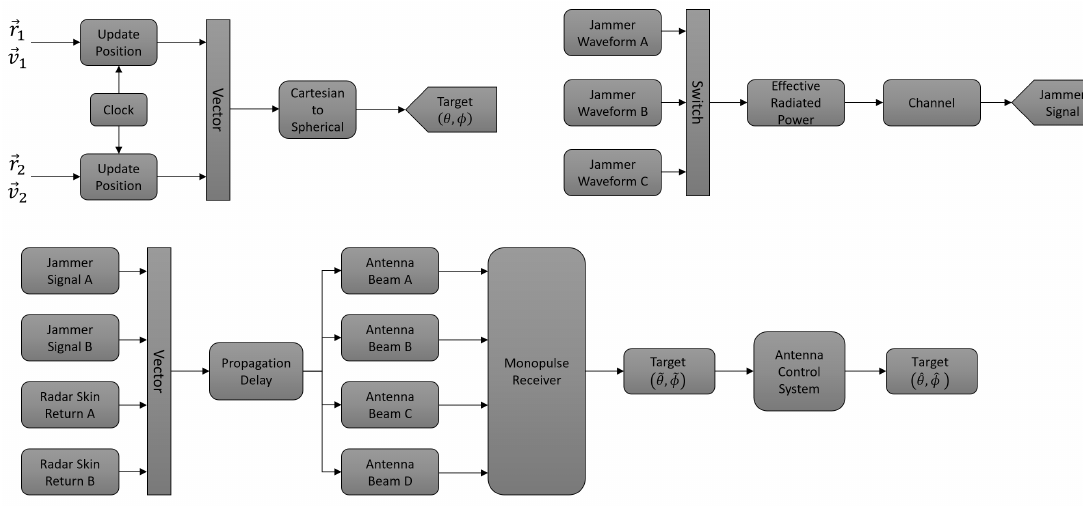
Figure 6. The monopulse tracking radar model Field Programmable Gate Array (FPGA) implementation and testbed in